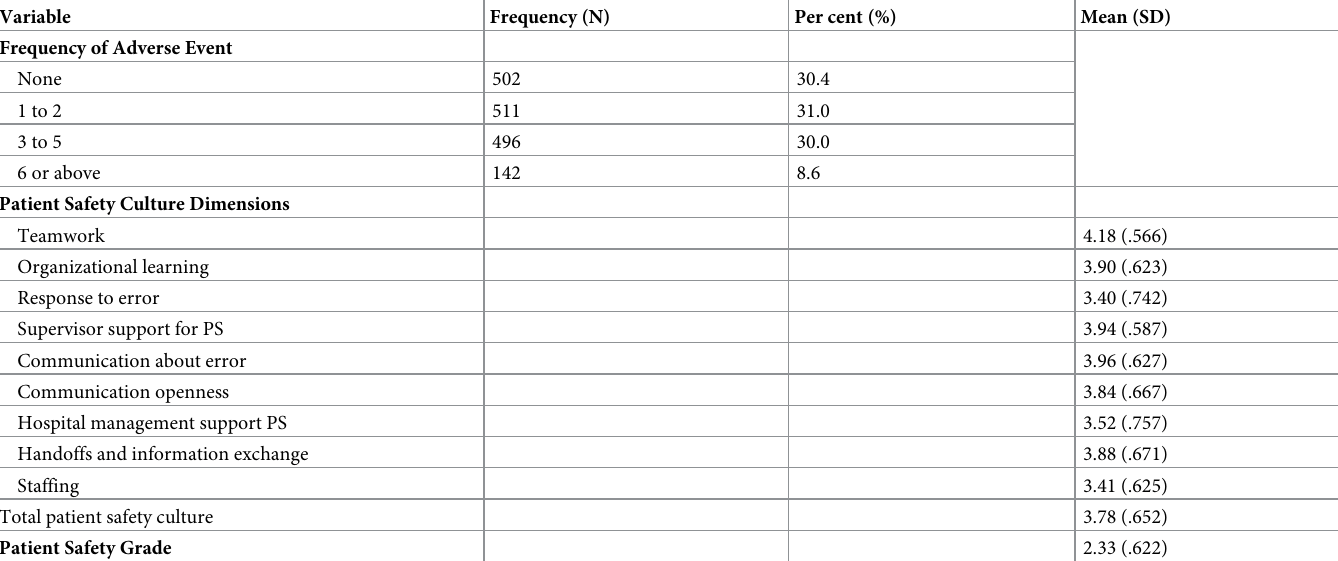
Table 2. Descriptive statistics of adverse events frequency and patient safety culture.